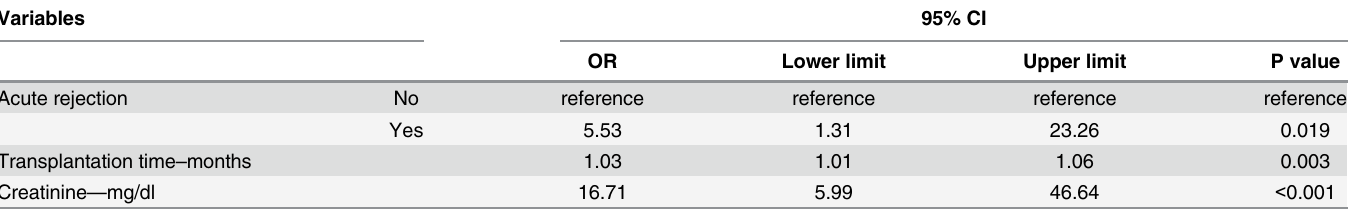
Table 4. Risk factors for renal replacement therapy at hospital discharge: multivariate analysis.